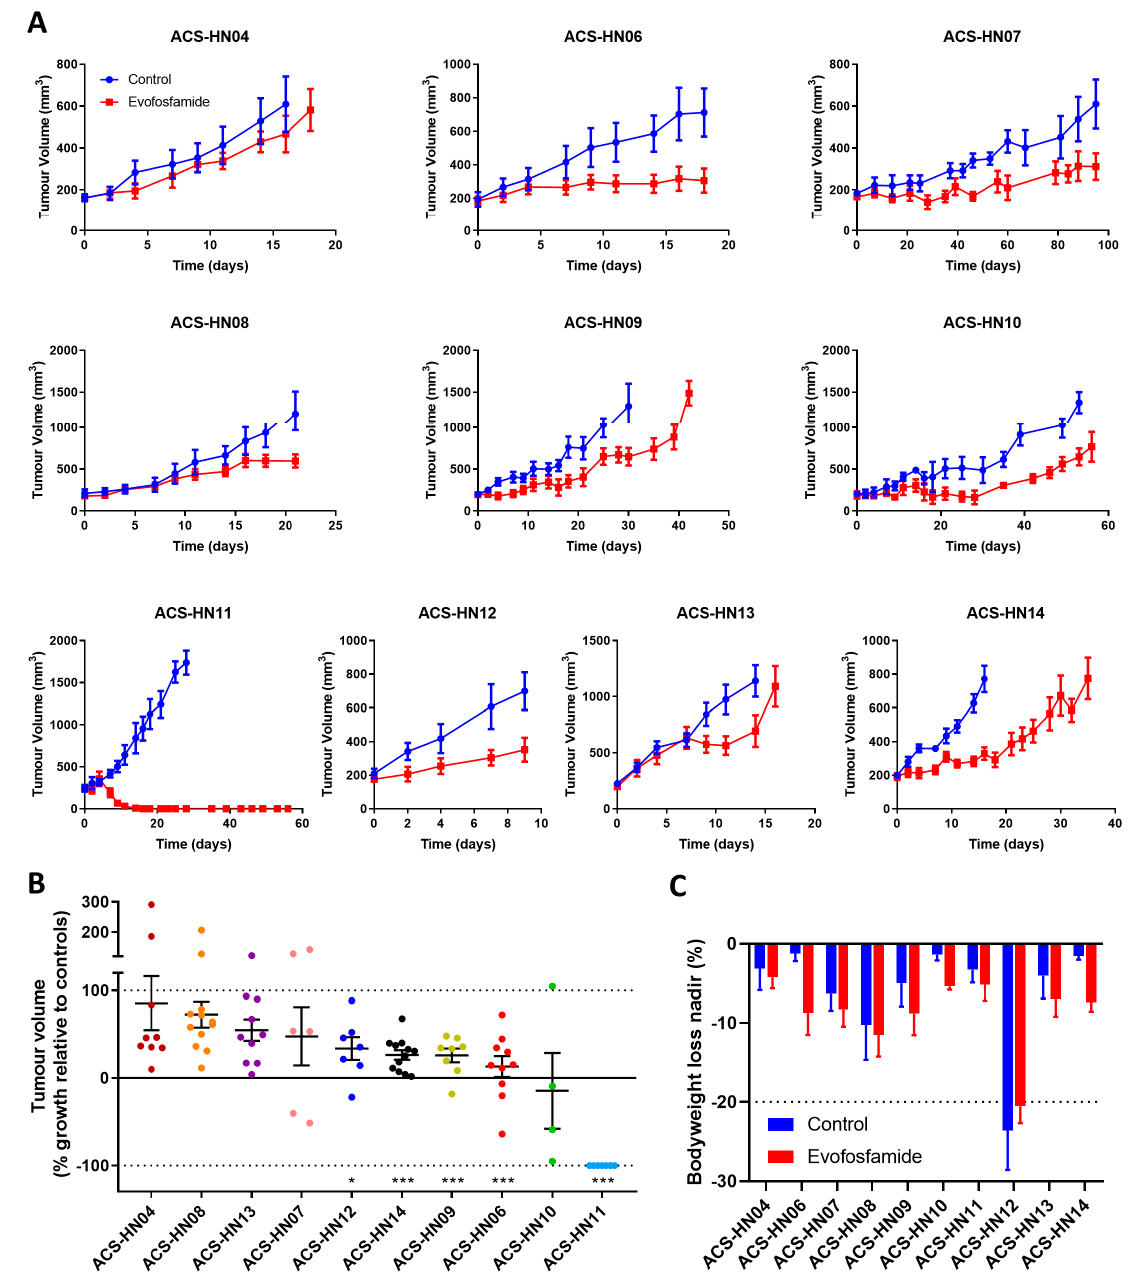
Figure 2. Anticancer e ffi cacy of evofosfamide in ten head and neck squamous cell carcinoma (HNSCC) PDX models. NOD scid or NIH-III mice with P3 PDX tumours were treated with 50 mg / kg evofosfamide by IP injection qd × 5 for three weeks or control vehicle. ( A ) Average tumour growth. ( B ) Waterfall plot of tumour growth in evofosfamide-treated mice presented as change in tumour volume from starting size relative to the average control value at the end of treatment (or endpoint if earlier). The dotted line at 100% represents equal growth to controls, the dotted line at − 100% represents complete regression and the line at 0% represents starting tumour size prior to treatment. * P < 0.05; *** P < 0.001 compared to controls by student’s T-test. ( C ) Bodyweight loss nadir in mice over the duration of the study. The dotted line at − 20% indicates weightloss endpoint. Data in each plot represent either individual values or the mean ± SEM for n = 7–12 tumours (except ACS-HN10: n = 3–4).